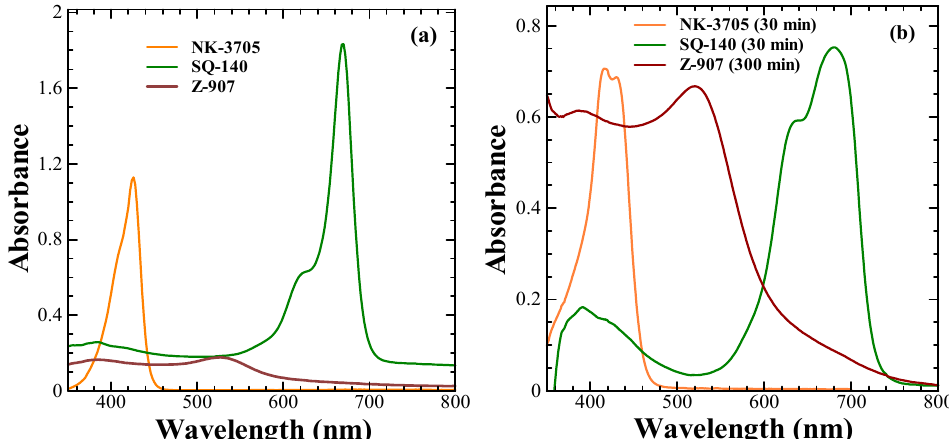
Figure 1. Electronic absorption spectra of NK-3705, Z-907, and SQ-140 in the solution of 10 µ m ethanol solution ( a ) and solid-state absorption spectra of these dyes adsorbed onto TiO 2 thin films ( b ). The values shown in parentheses are the time taken for dye adsorption on 6 µm transparent TiO 2 thin fi lms to measure the solid-state absorption spectra.